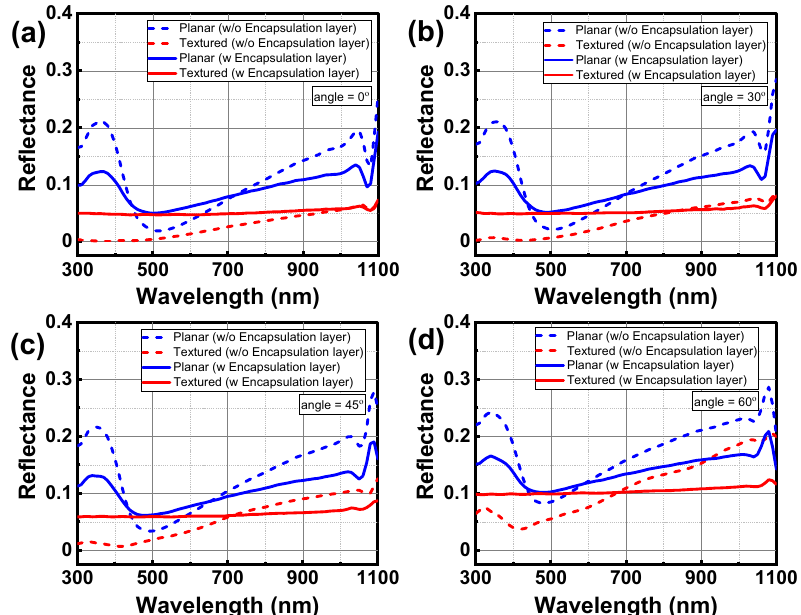
Figure 10. Calculated reflectance spectra of the surface-textured CIGS solar cell without and with the inclusion of the front incoherent layers. The RMS surface roughness of the surface-textured structure is set to be σ RMS = 100 nm. For reference, the reflectance spectra of the planar CIGS solar cell are also calculated. The incidence angle of the AM 1.5 sunlight is θ 0 = ( a ) 0 ° , ( b ) 30 ° , ( c ) 45 ° , and ( d ) 60 ° , respectively.